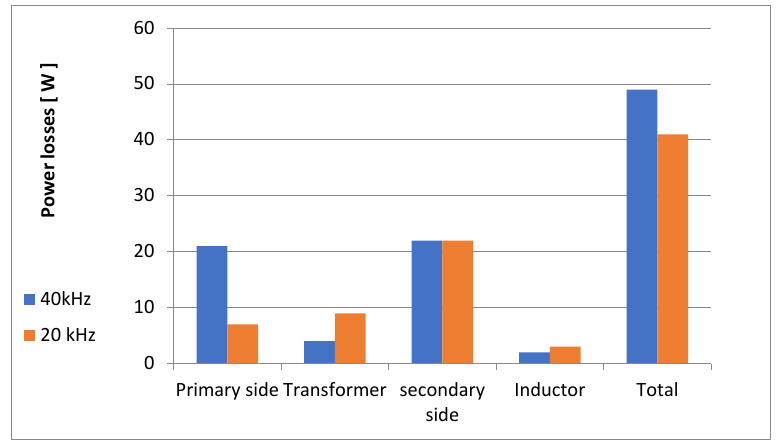
Figure 13. Power loss analysis.